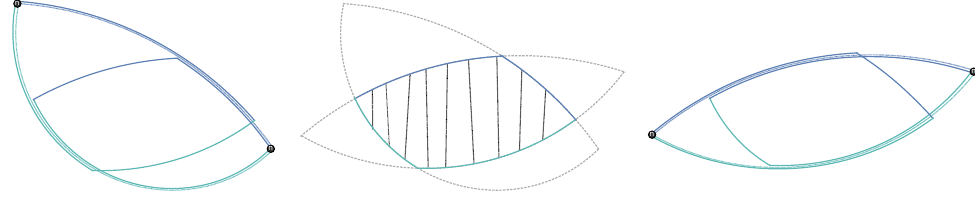
Figure 24 . The two alternative OPE decompositions of the 4pt function G (cid:15)(cid:14)(cid:15)(cid:14)